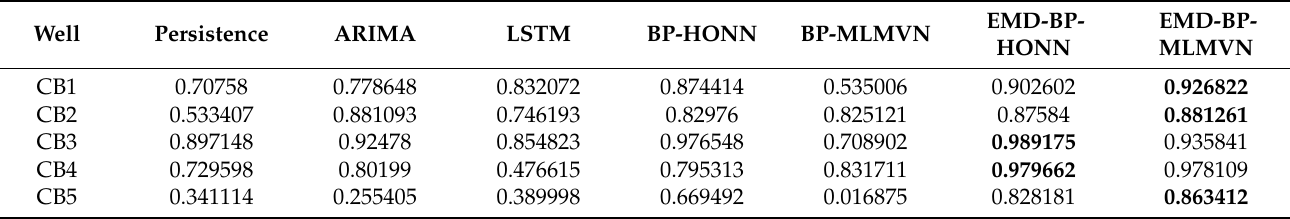
Table 6. Result of CB oilfield in R 2 metric. The highest score is in